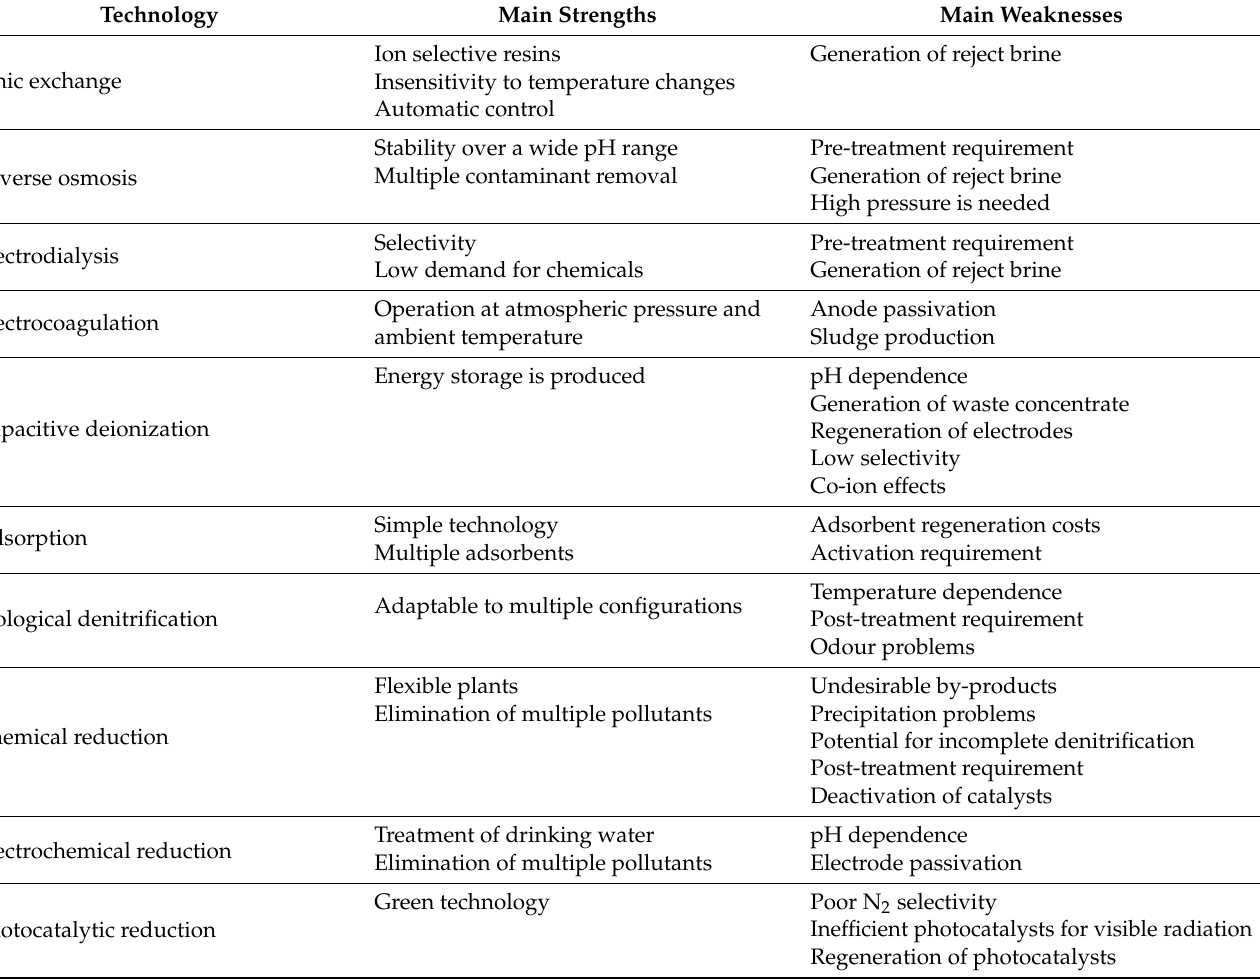
Table 2. Strengths and weaknesses of nitrate removal